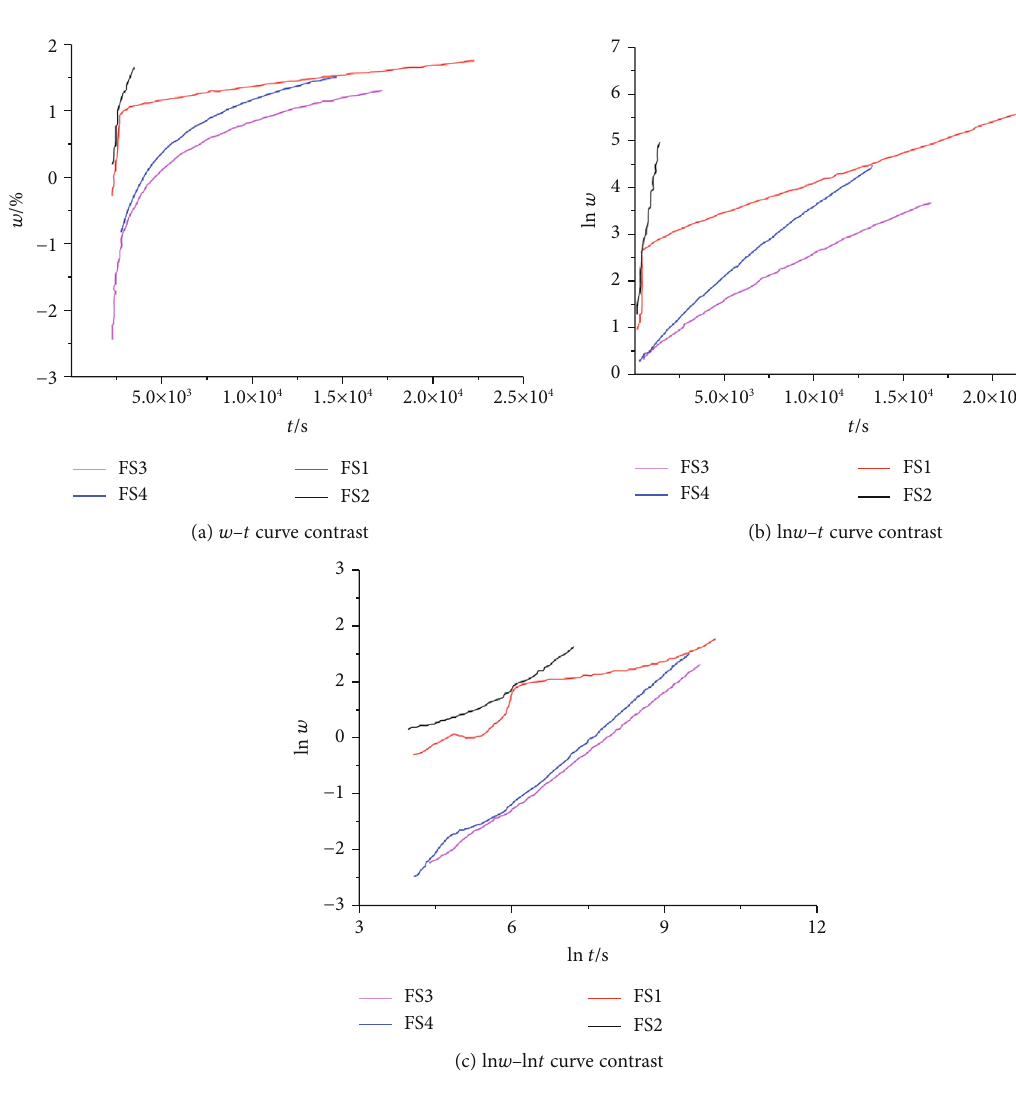
Figure 20: Siltstone has pressure water absorption correlation curve.